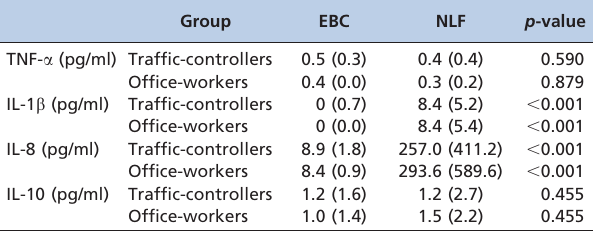
Table 2 - Cytokines concentrations in the exhaled breath condensate and nasal lavage fluid of the traffic- controllers and office-workers. The data were analyzed by the Kruskal-Wallis test and Bonferroni post-hoc test. The results are presented as median values